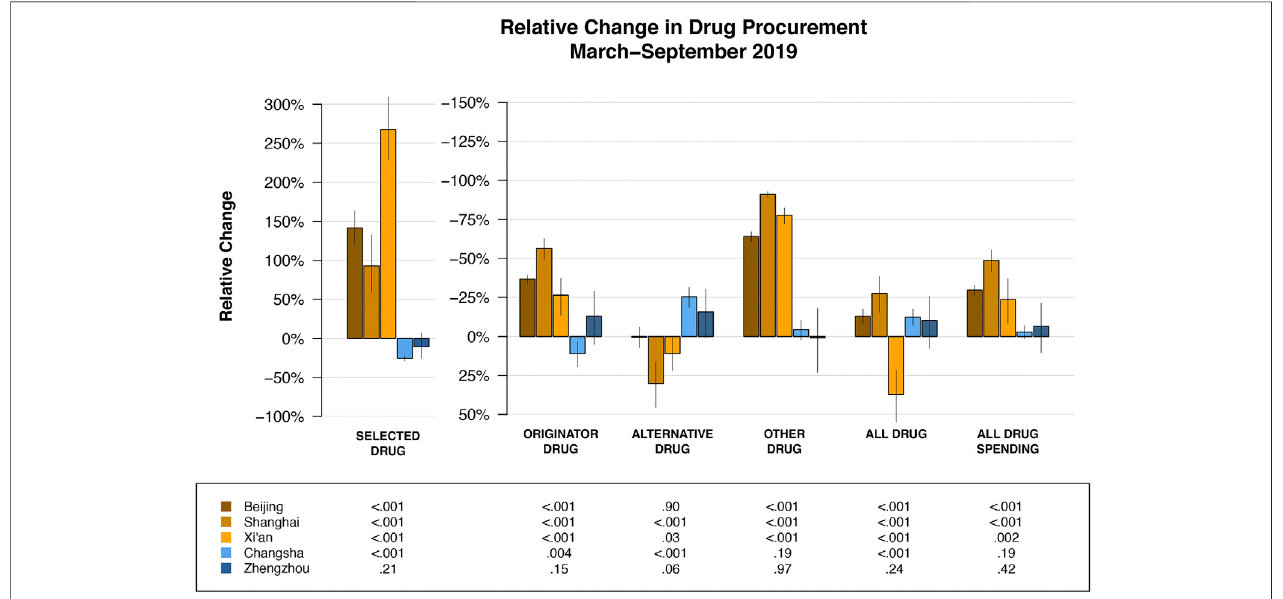
FIGURE 3 | Relative change in drug purchase compared to expected purchase (had the pilot reform not occurred) by cities and drug categories. Speci fi c point estimates for relative change and the corresponding 95% con fi dence intervals are provided in Supplementary Table S4 .